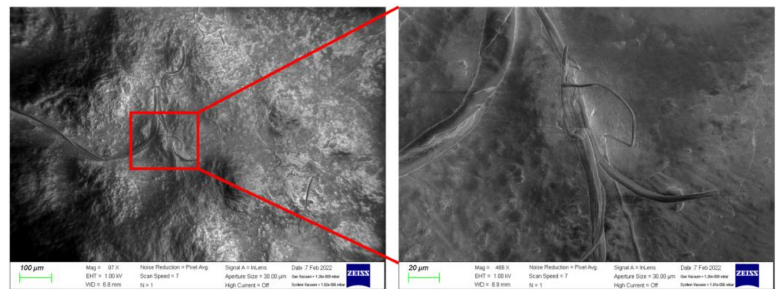
Figure 13. SEM images of the CNTs Composite Dielectric Layer (CNTs +